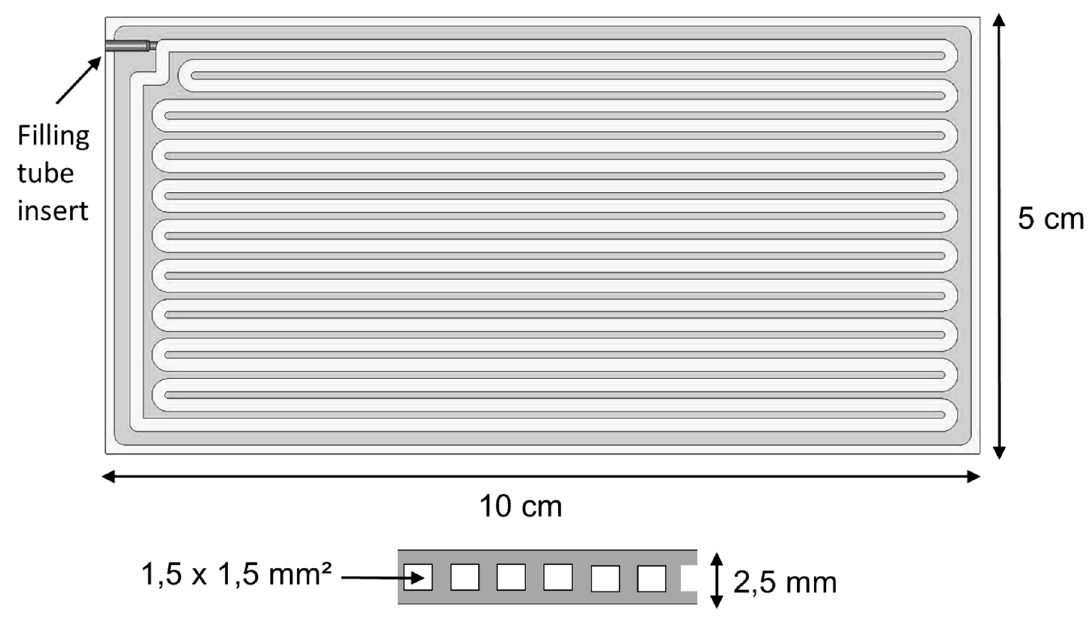
Figure 1. Channel structure and dimensions (50 × 100 × 2.5 mm 3 ) of fabricated pulsating heat pipe (PHP) with channel size of 1.5 × 1.5 mm 2 . Top: top view. Bottom: cross section showing channel structure.